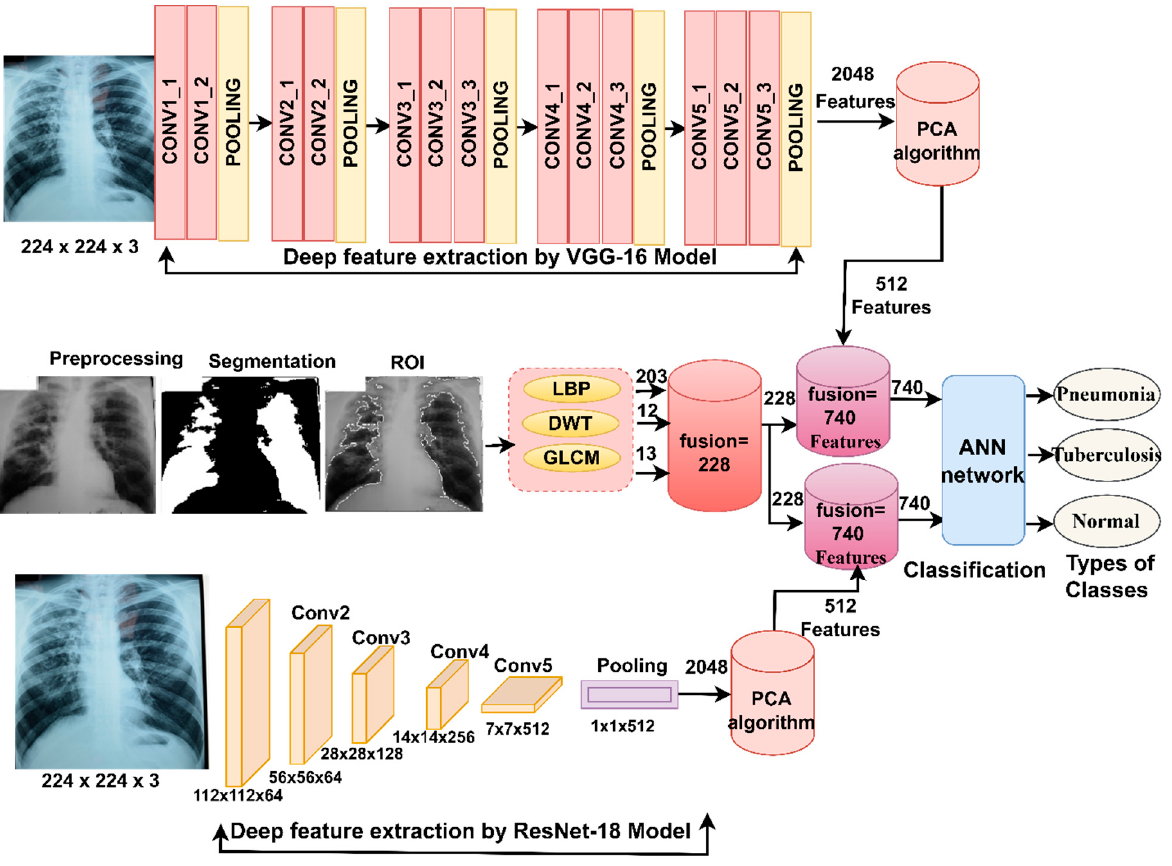
Figure 5. Structure framework of the technique for early diagnosis and discrimination of pneumonia and tuberculosis by ANN, based on the fusion of CNN features with hand-crafted features.